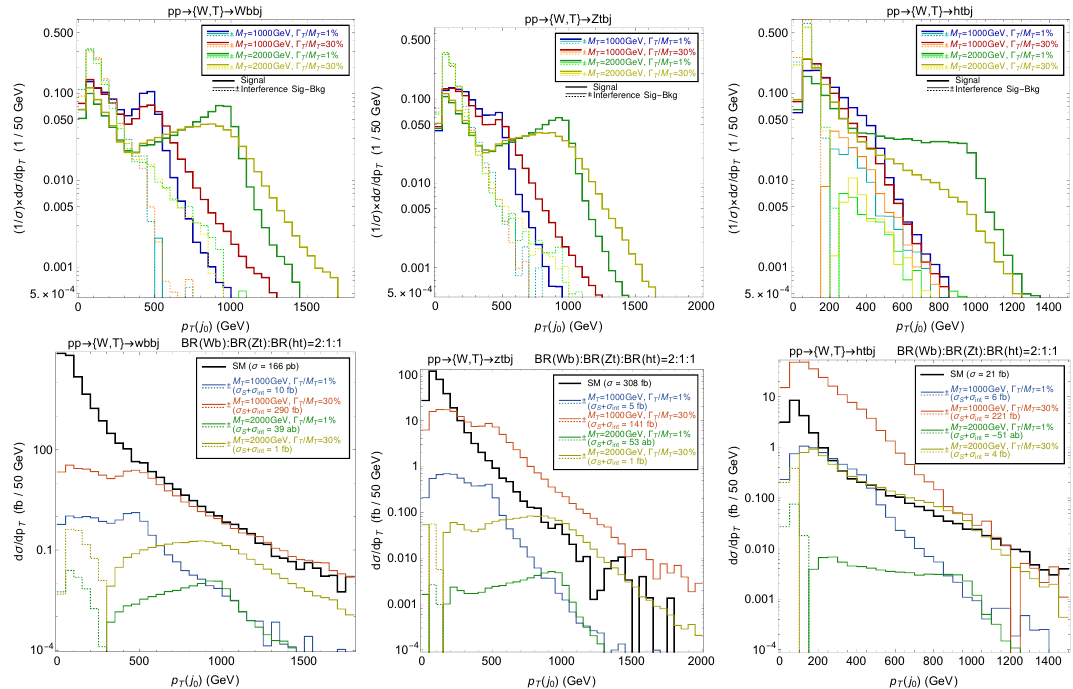
Figure 11 . Same as figure 10 for the distribution in the p T of the leading light jet. Analogous results for T production through Zt exchanges are shown in figure